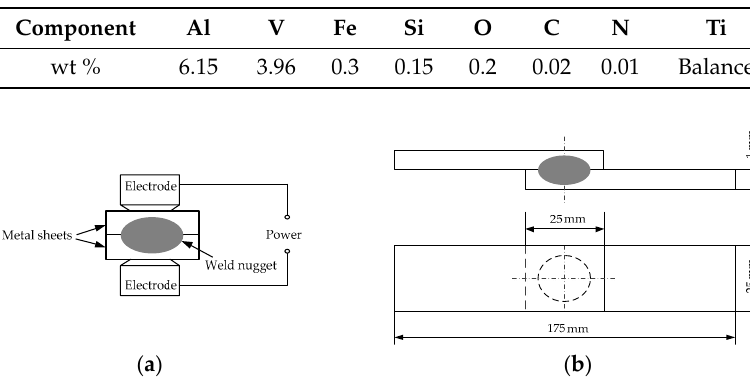
Table 1. Chemical composition of Ti6Al4V titanium alloy (wt %).